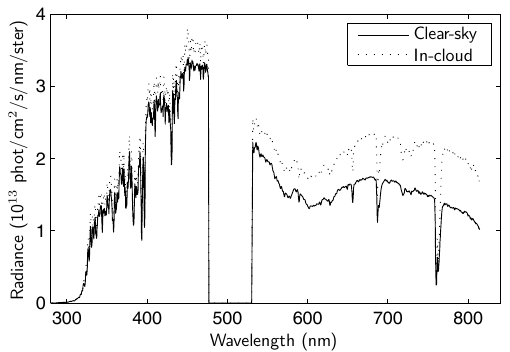
Fig. 2. OSIRIS in-cloud radiance shown with respect to clear-sky radiances observed at the same altitude.